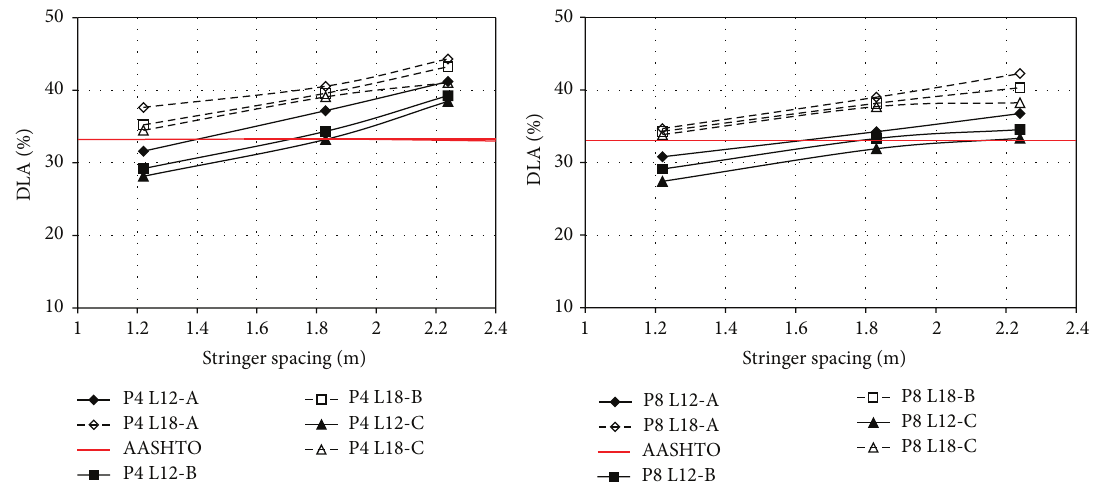
Figure 10: Relations between stringer spacing and DLA.